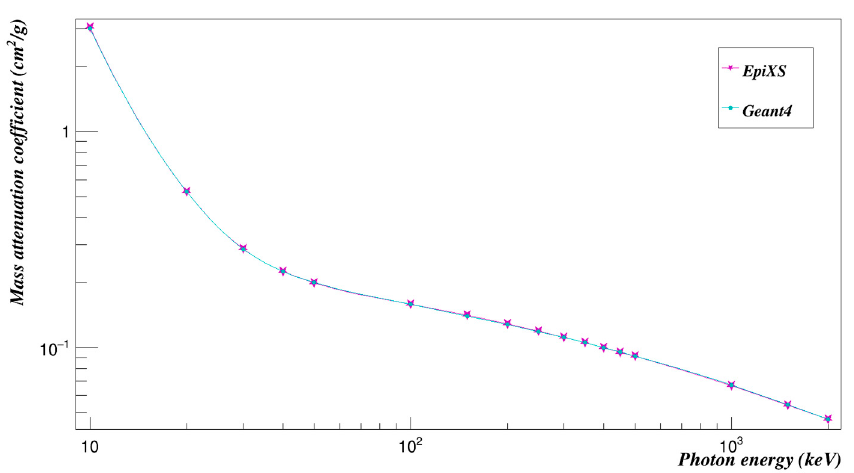
Figure 3. Validation of Geant4 results of the mass attenuation coefficients by those found by EpiXS. Table 1. Half value layers of the investigated Polyimide as found by EpiXS and Geant4.